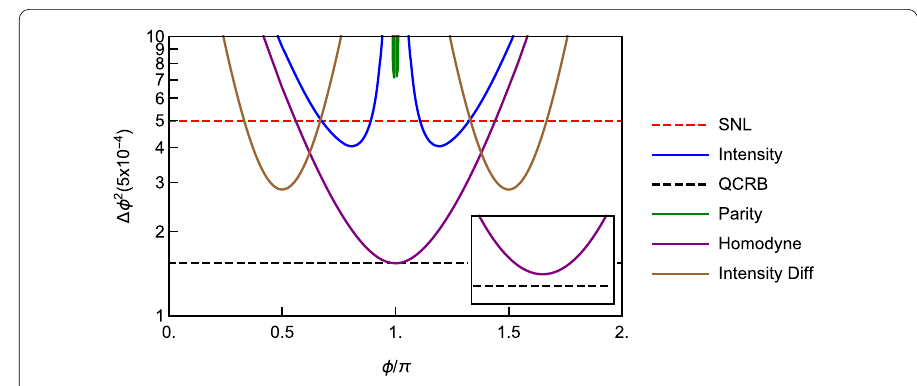
Figure 2 Log plot of phase variance for various detection schemes for a coherent state and squeezed vacuum into an MZI, as a function of the unknown phase difference φ . Loss parameters have been set to L = 20%. Input state parameters for each respective state are set to | α | 2 = 500 and r = 1. SNL and QCRB